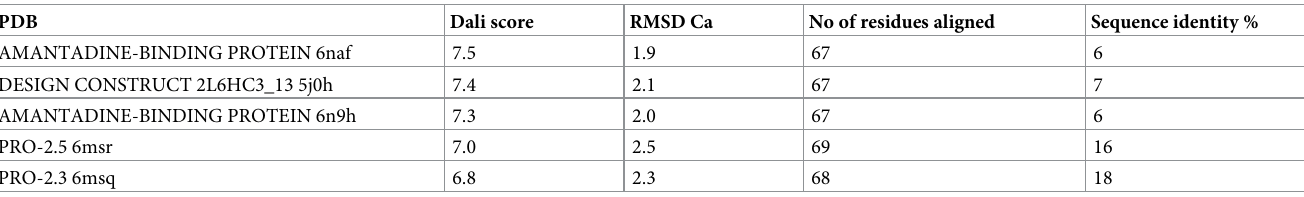
Table 1. Structural homologs of α 1/ α 2 helices of human ACE2.